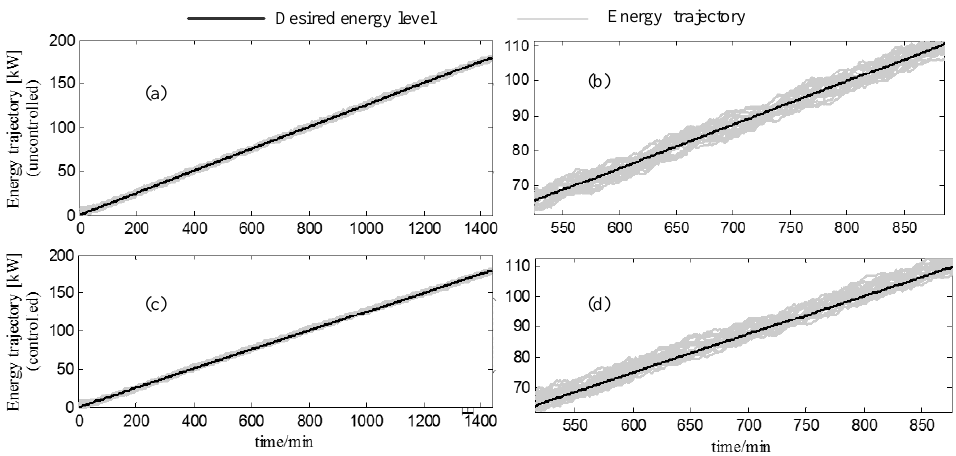
Figure 10. Energy trajectory of a single demand side electrolyzers for ( a ) the uncontrolled case; ( b ) the uncontrolled case in the magnified time range; ( c ) the controlled case; and ( d ) the controlled case in the magnified time range.